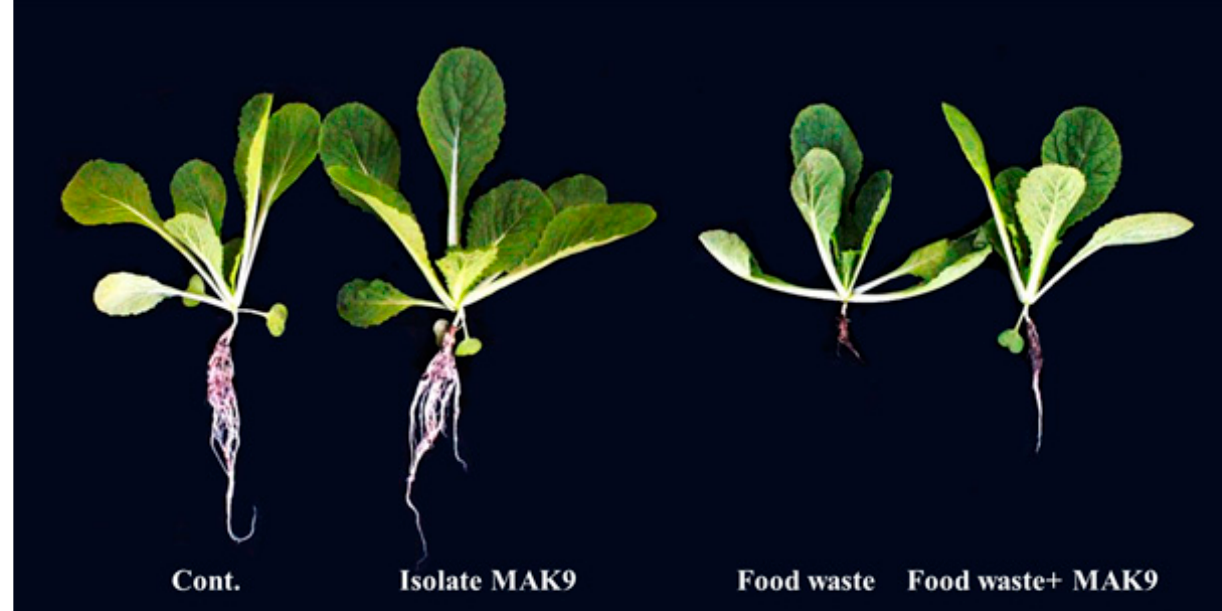
Figure 3. Effects of bacterial isolate MAK9 on the growth of Chinese cabbage and on the effects of food waste (8%) appli- cation.